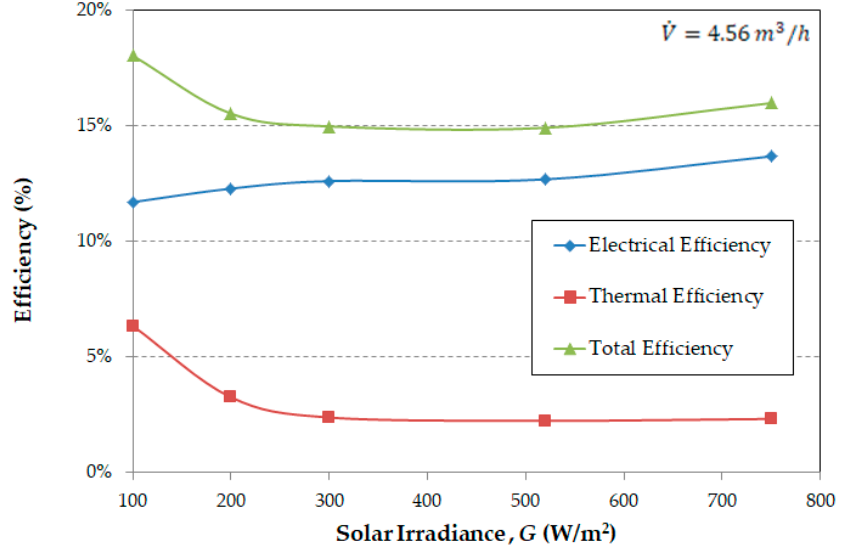
Figure 7. Efficiency changes depending on solar irradiance for a modified PV module, cooled by fans with the intensity of air flow at 𝑉(cid:4662) = 4.56 (cid:2923)